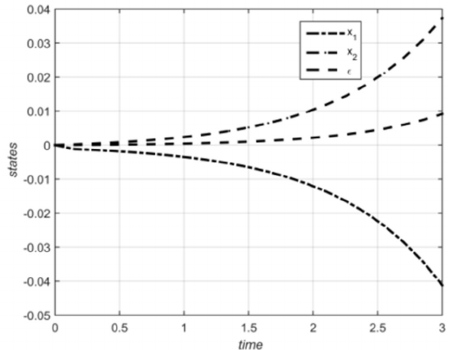
Figure 1. Trajectories of the closed-loop system